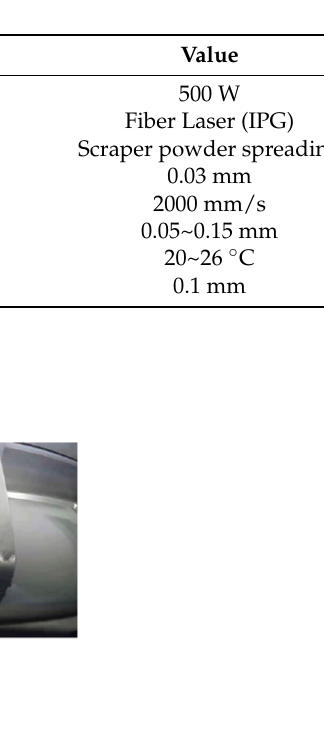
Figure 3. SLM printer and the printing process.